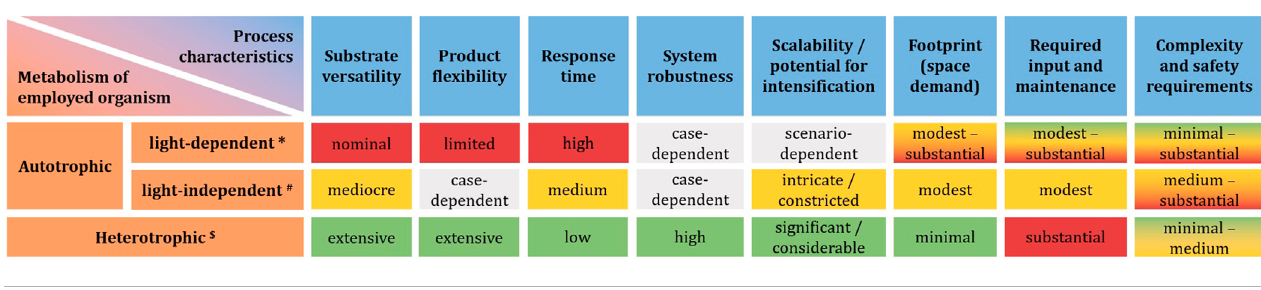
a strictly limited to phototrophy b lithotrophy, including carboxidotrophy, cathodic electro-fermentation (Chen et al., 2020b), and, exceeding the strict de fi nition of autotrophy, methanotrophy c including mixotrophs that can also operate in other chemotrophic and organotrophic